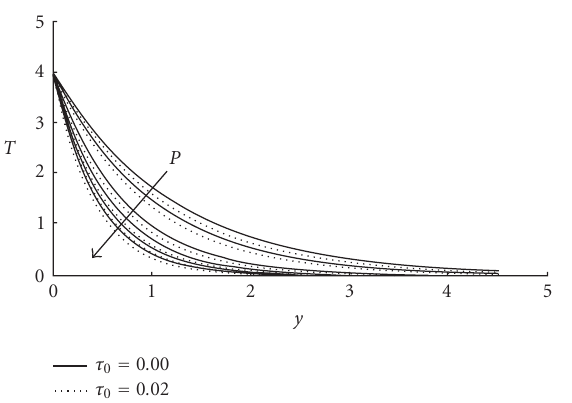
Figure 5.3. Temperature distribution for various values of Prandtl number P , where P = 0 . 7,1 . 0,2 . 0,3 . 0,4 . 0, 5 . 0.